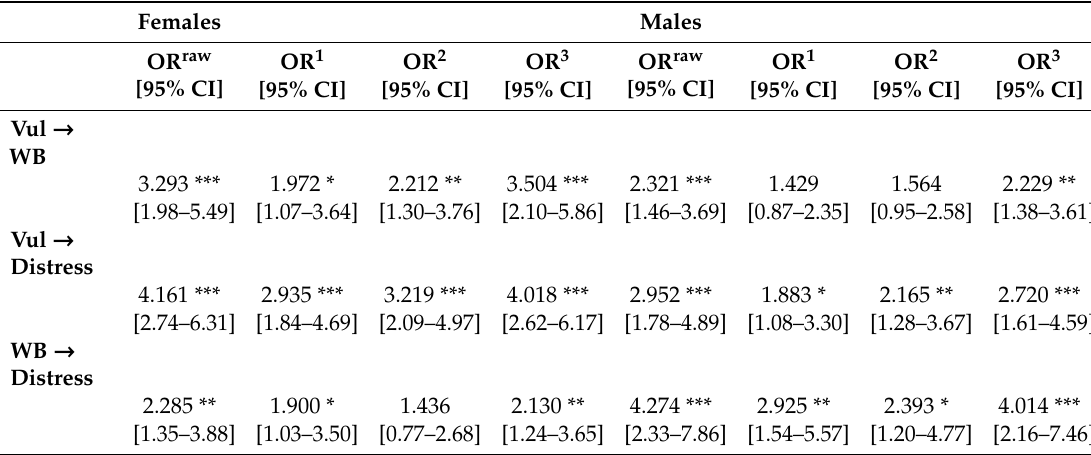
Table 2. Associations between workplace vulnerability and risk of exposure to workplace violence and psychological distress, and between workplace violence and risk of exposure to psychological distress while controlling for workplace vulnerability in women and